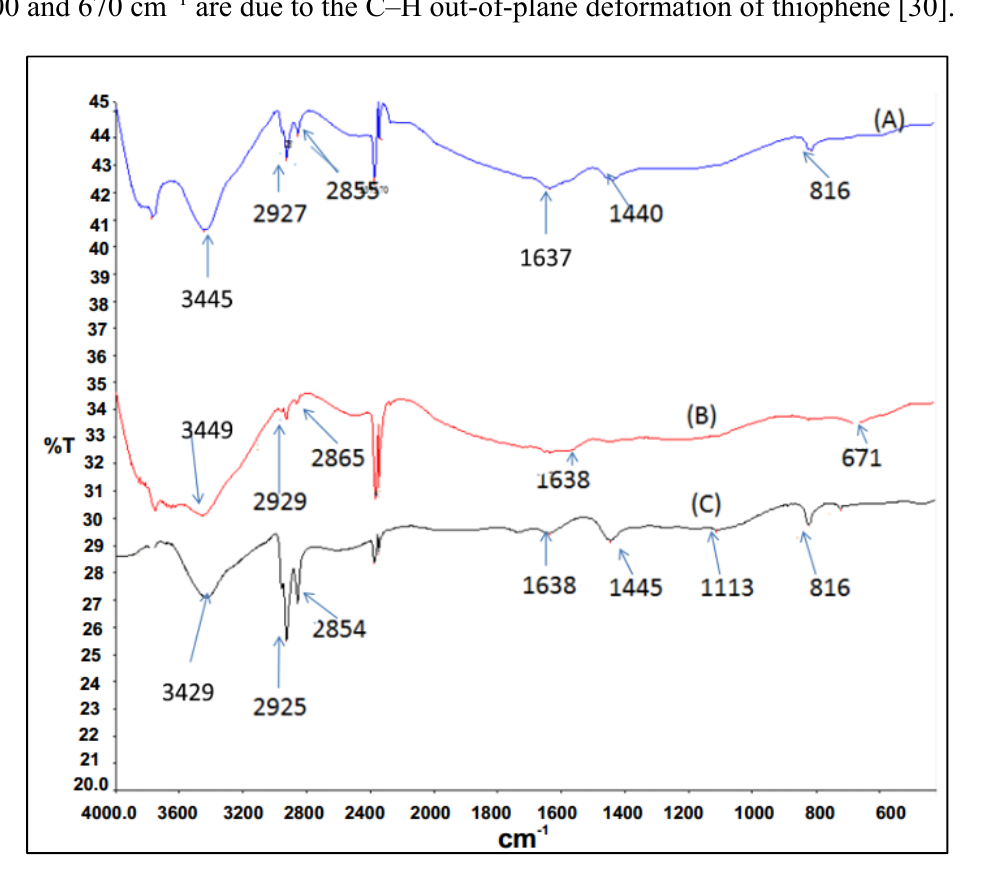
Figure 5. FTIR absorption frequencies for P3HT and nanocomposites (A) P3HT; (B) in situ ; (C) direct